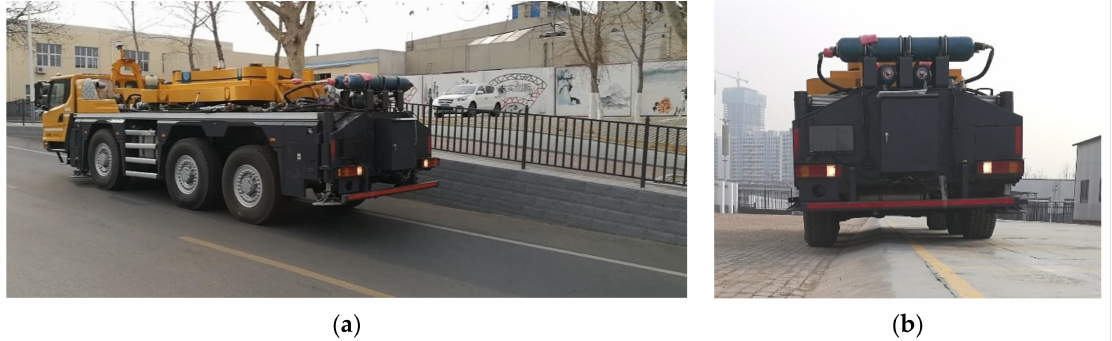
Figure 15. Slope road experiment: ( a ) longitudinal slope road experiment; ( b ) cross slope road experiment. (2) Cross slope road experiment